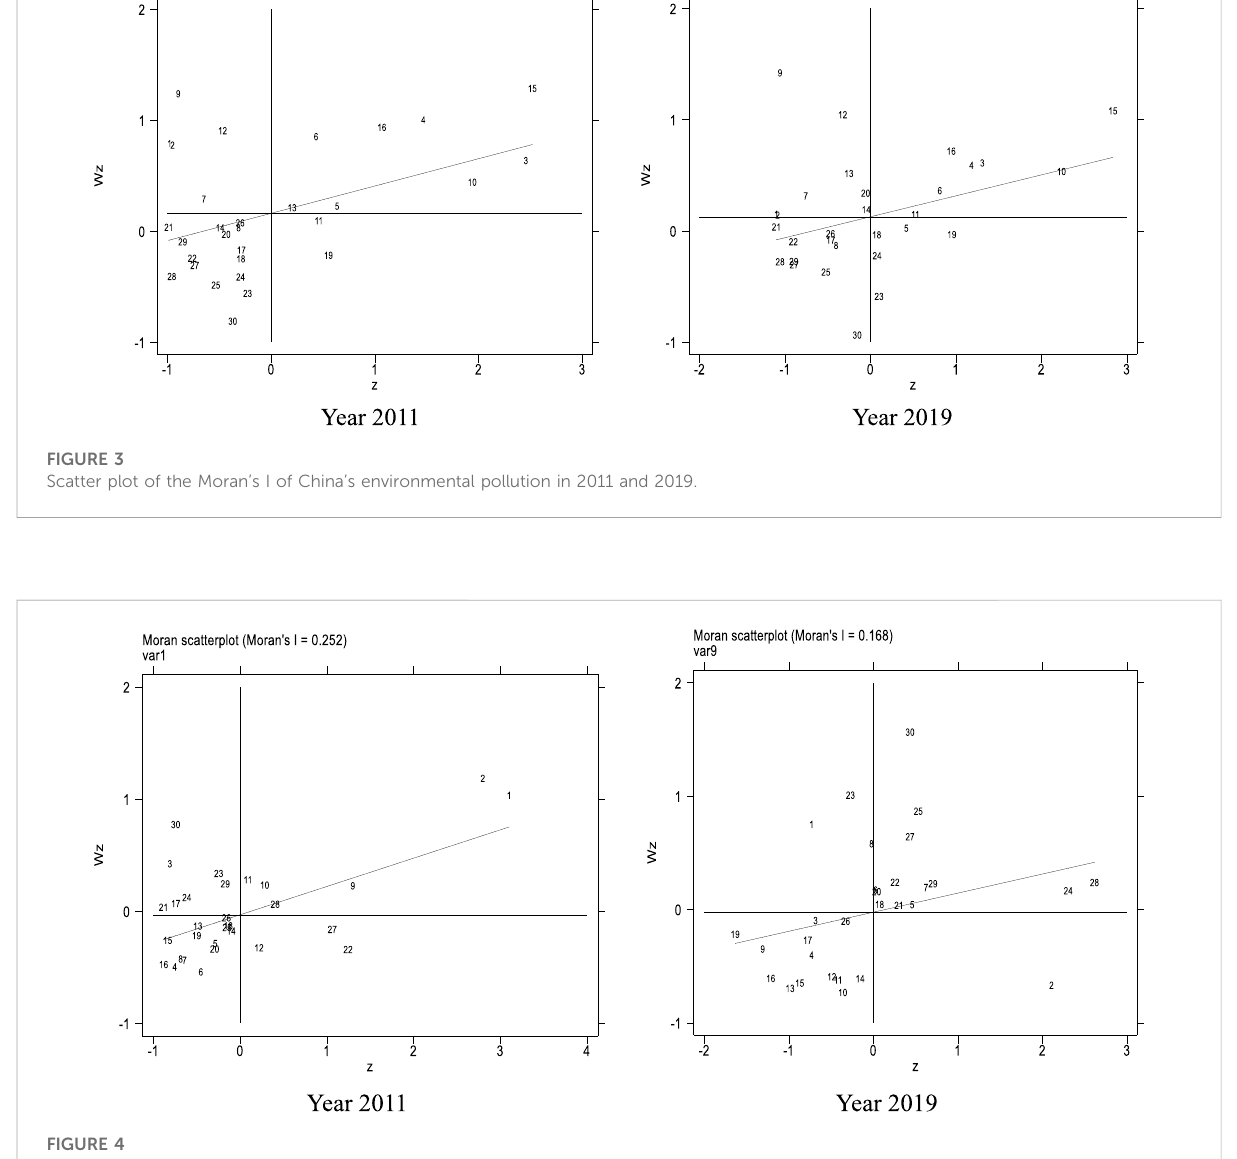
FIGURE 4 Scatter plot of the Moran ’ s I of China ’ s local government debt in 2011 and